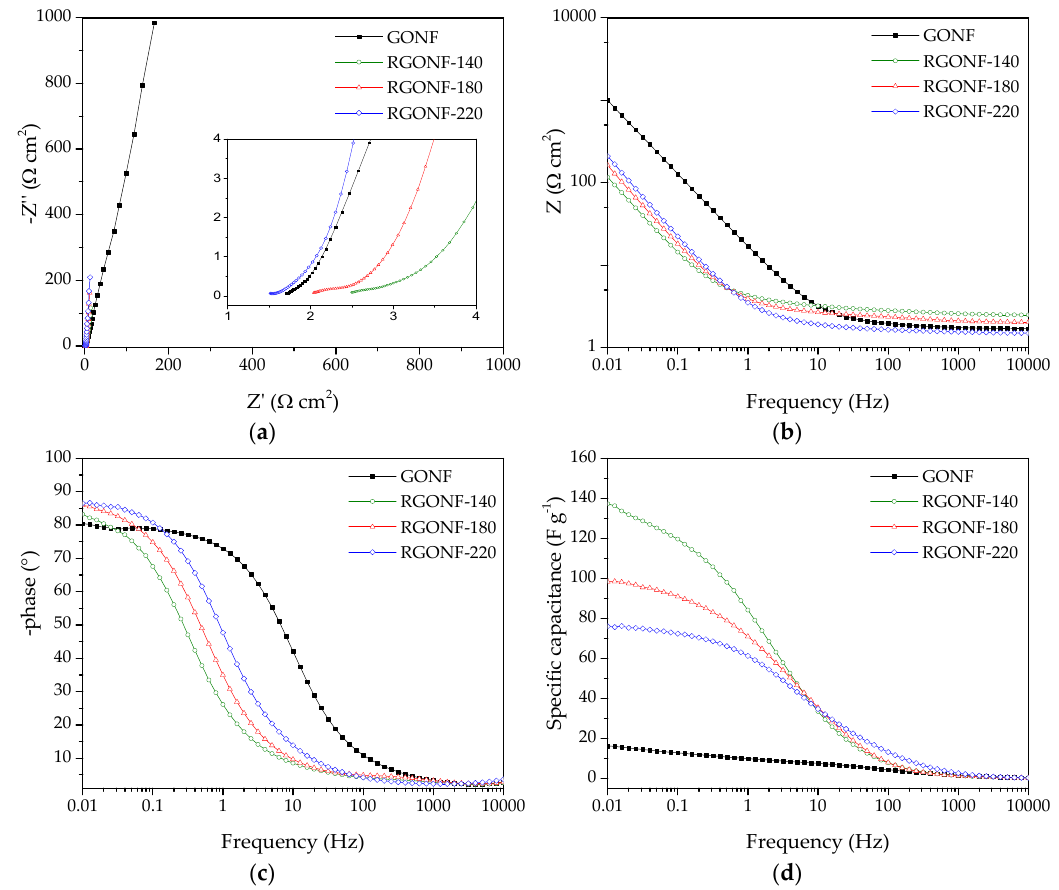
Figure 8. ( a ) Nyquist impedance plots with a 10 mV AC amplitude around 0.5 V of GONF and RGONFs. ( b ) Frequency-dependent impedance modulus Bode plots with a 10 mV AC amplitude around 0.5 V. ( c ) Frequency-dependent phase angle Bode plots with a 10 mV AC amplitude around 0.5 V. ( d ) Specific capacitance vs. frequency curves with a 10 mV AC amplitude around 0.5 V of GONF and RGONFs. Aqueous electrolyte: 0.5 M H 2 SO 4 .